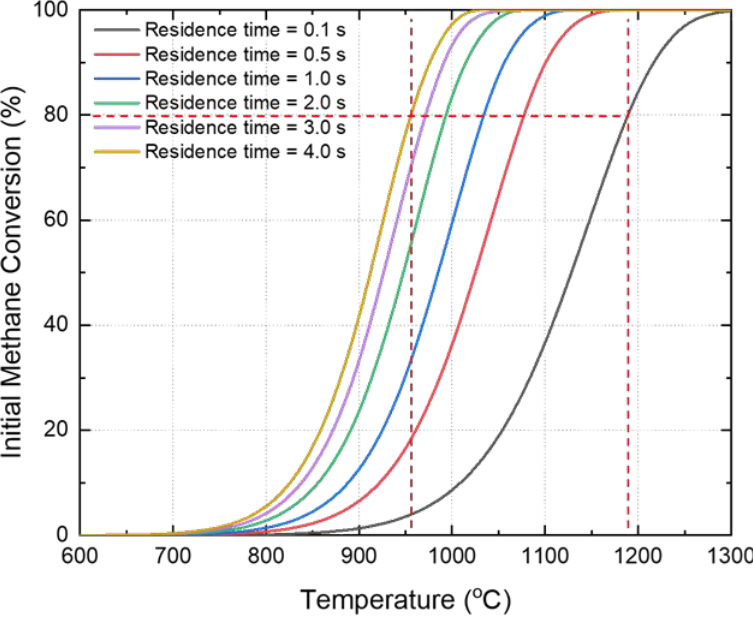
Figure 18. Effect of residence time and temperature on the initial methane conversion using BP-2000.